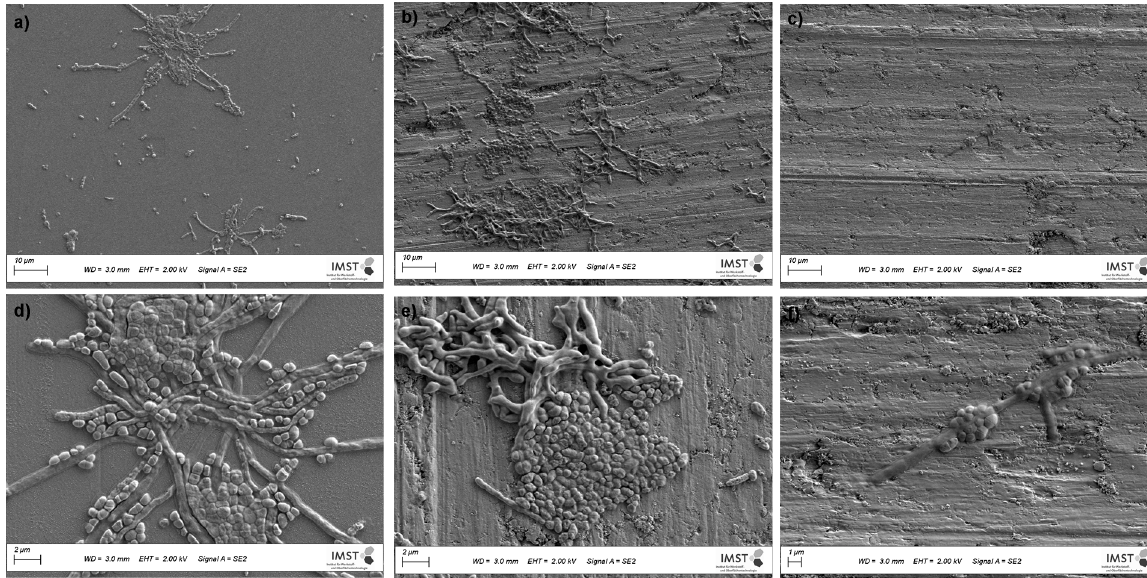
Figure 8. Biofilm formation on specimen surfaces: ( a – f ) show fluorescence micrographs of PI-stained plaque cultures after 72 h incubation on coverslips ( a , d ), TiCP (ar) ( b , e ) and polySBMA coatings ( c , f ).